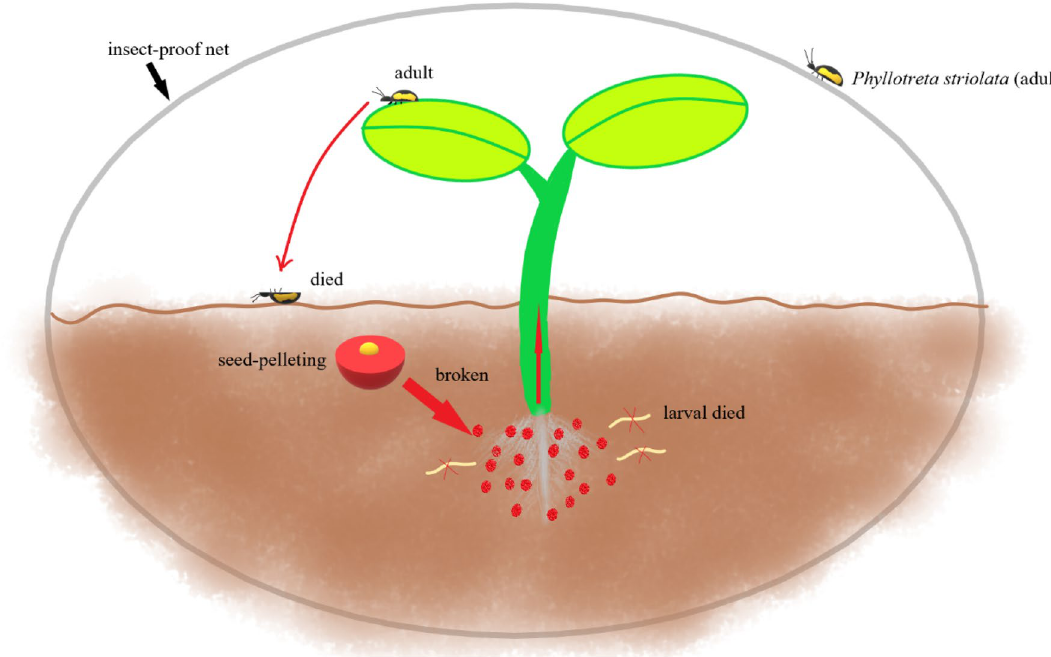
Figure 1. The use of a seed-pelletized coating of spinetoram effectively reduced SFB feedings on the flowering cabbage seedlings, whereas in combination with the insect-proof net, it controlled the SFB infestation throughout the cabbage growth